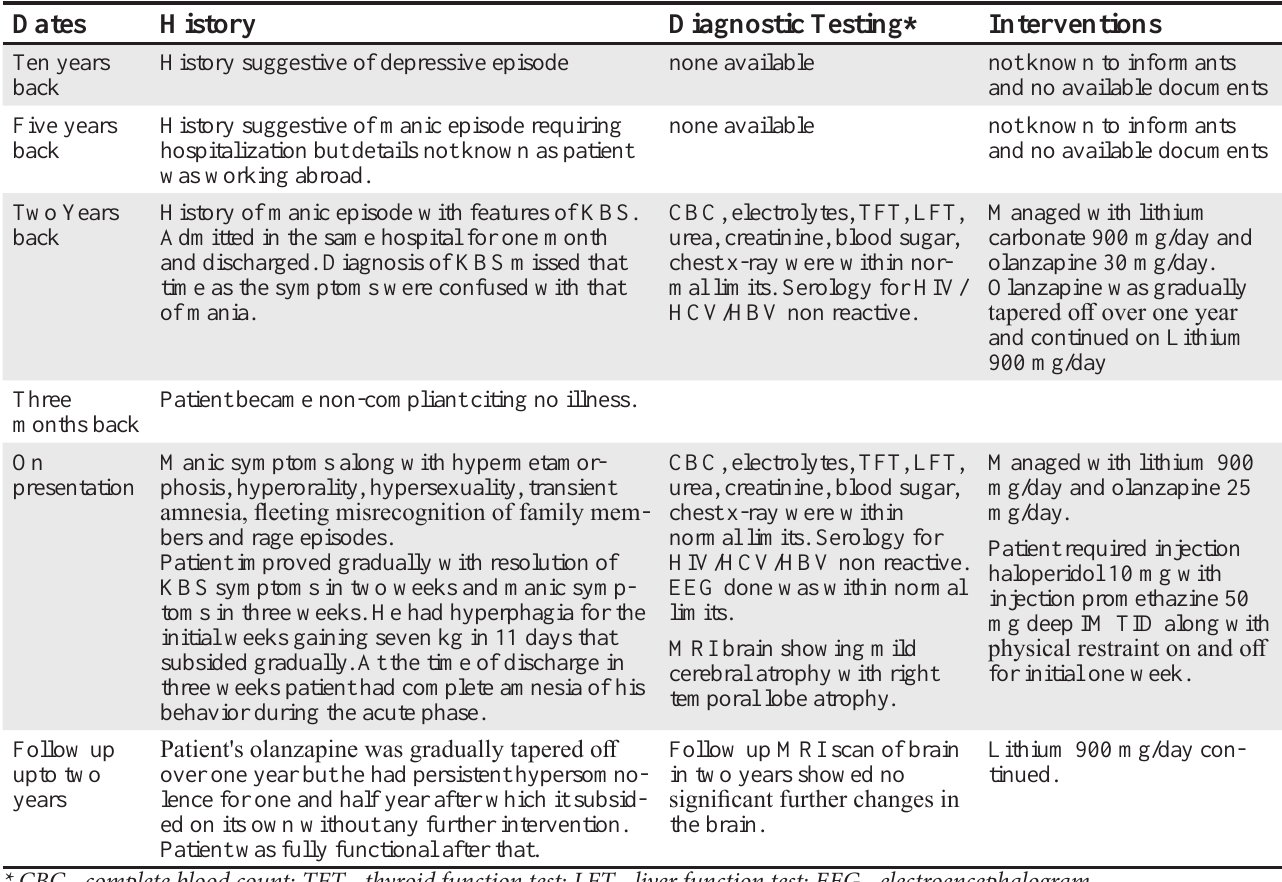
Table 1 : Timeline of the patient's history, diagnostic work-up, and